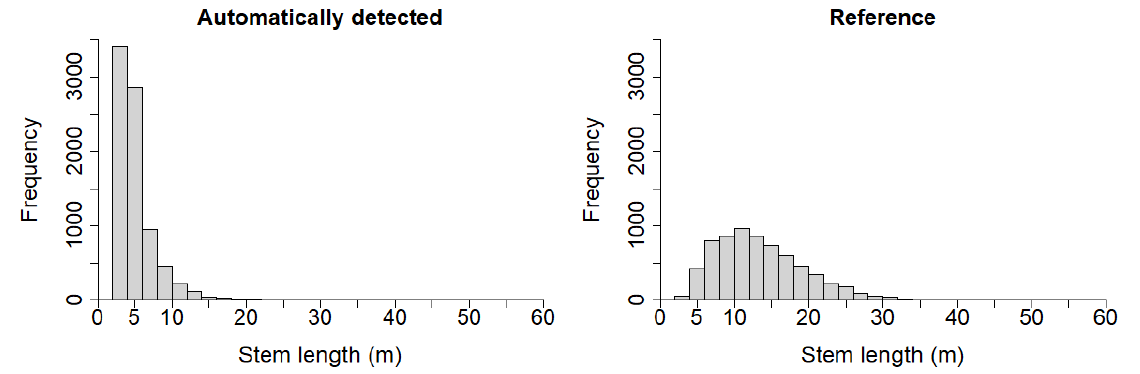
Figure 14. Distribution of the stem lengths.